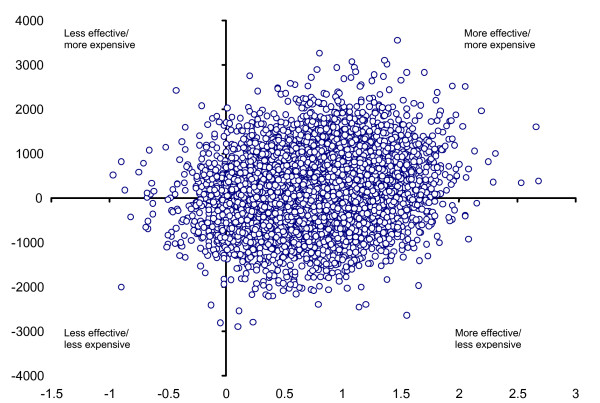
Cost-effectiveness plane comparing surgery and splinting for number of nights awake due to symptoms.